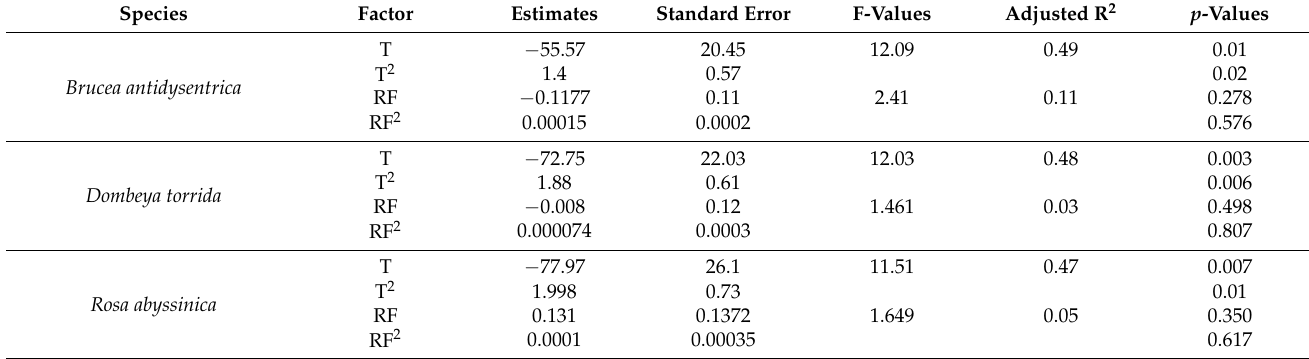
Figure 10. The patterns of flowering intensity in relation to the monthly temperature: ( a ) Brucea antidysenterica , ( b ) Dombeya torrida , ( c ) Rosa abyssinica. Table 2. The non-linear quadratic polynomial regression model fits showing the effect of average monthly temperature (T) and rainfall (RF) on the flowering percent of tree